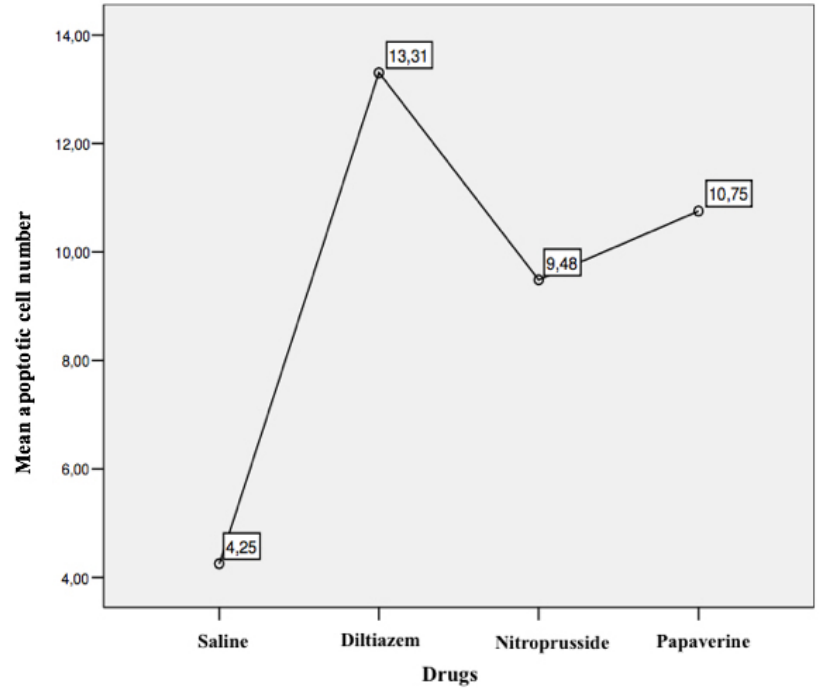
Fig. 1 - Mean apoptotic cell counts of the groups.